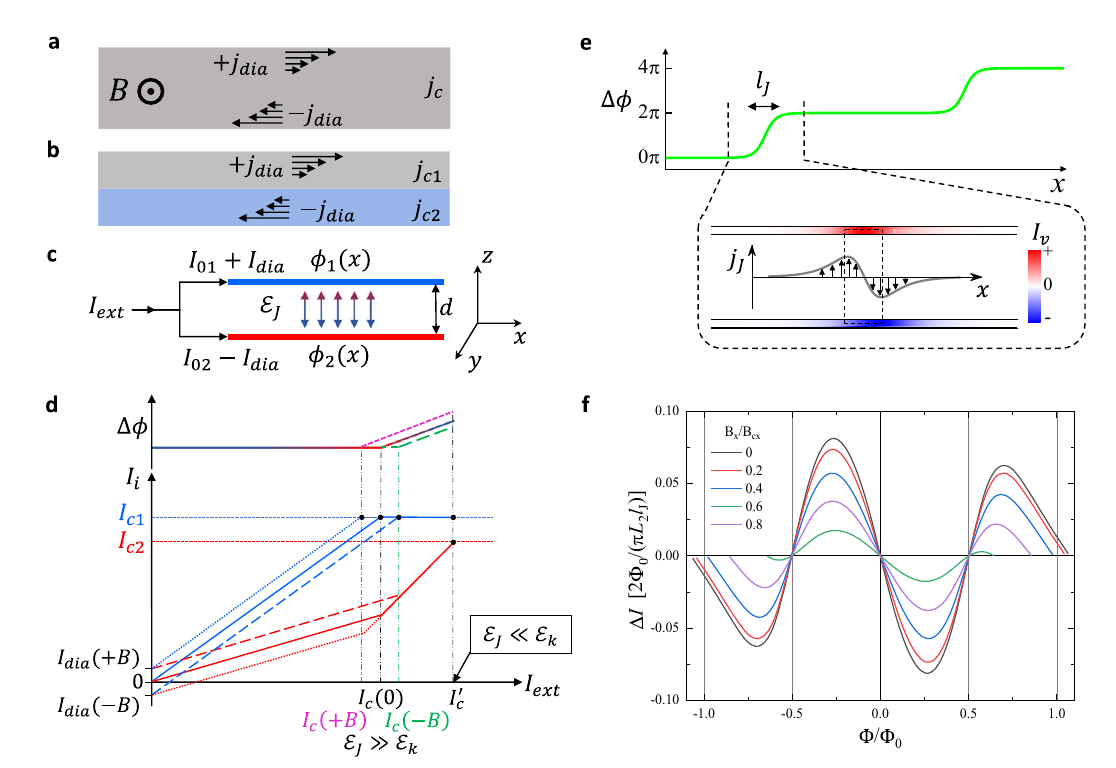
Fig. 4 | Nonreciprocity of the critical current in the presence of diamagnetic currents. Diamagnetic currents in ( a ) a uniform superconductor and ( b ) a het- erostructure. c A two-layer heterostructureismodeled astwo zerothickness wires separated by a distance d with coupling described by the Josephson energy E J . d Schematic of current distribution between the wires I i = I 0 i − ( − 1) i I dia , i =1,2, and the phase difference Δ ϕ as a function of an external current I ext = I 1 + I 2 for B =0 (solid lines), B >0 (dotted lines) and B <0 (dashed lines).Forweakly coupled